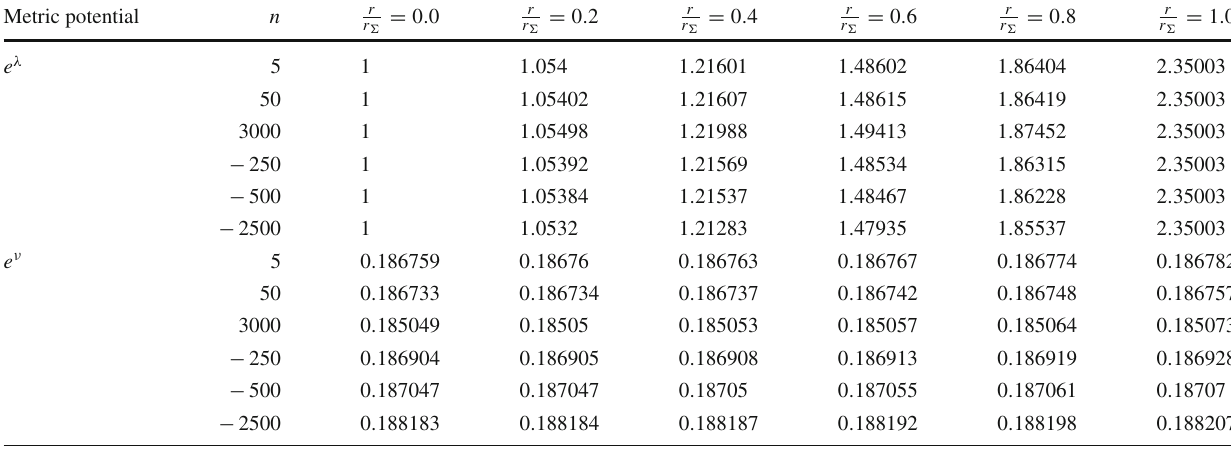
Table 2 The numerical values of the metric potential e λ and e ν are obtained by fixing b = 0 . 0095 for a compact star of mass M = 1 . 85 M (cid:3) and radius = 9 . 5km for different values of n Metric potential